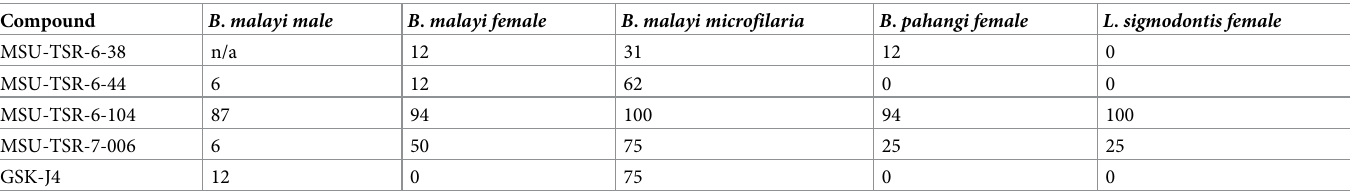
Table 1. Percent parasite motility by various synthetic inhibitors and GSK-J4. Parasites were treated with indicated compounds at 1 μ M for 48 hours. All experiments were repeated at least three times n = 3. Except for MSU-TSR-6-104 which is a structurally inactive analog and MSU-TSR-6-38, all compounds are selective towards adult parasitic stages. The compounds are also active against the closely related B . pahangi and the rodent nematode L . sigmodontis . All reported percent inhibition are within a � 10% standard error. All compounds are inactive against C . elegans at 100 μ M.